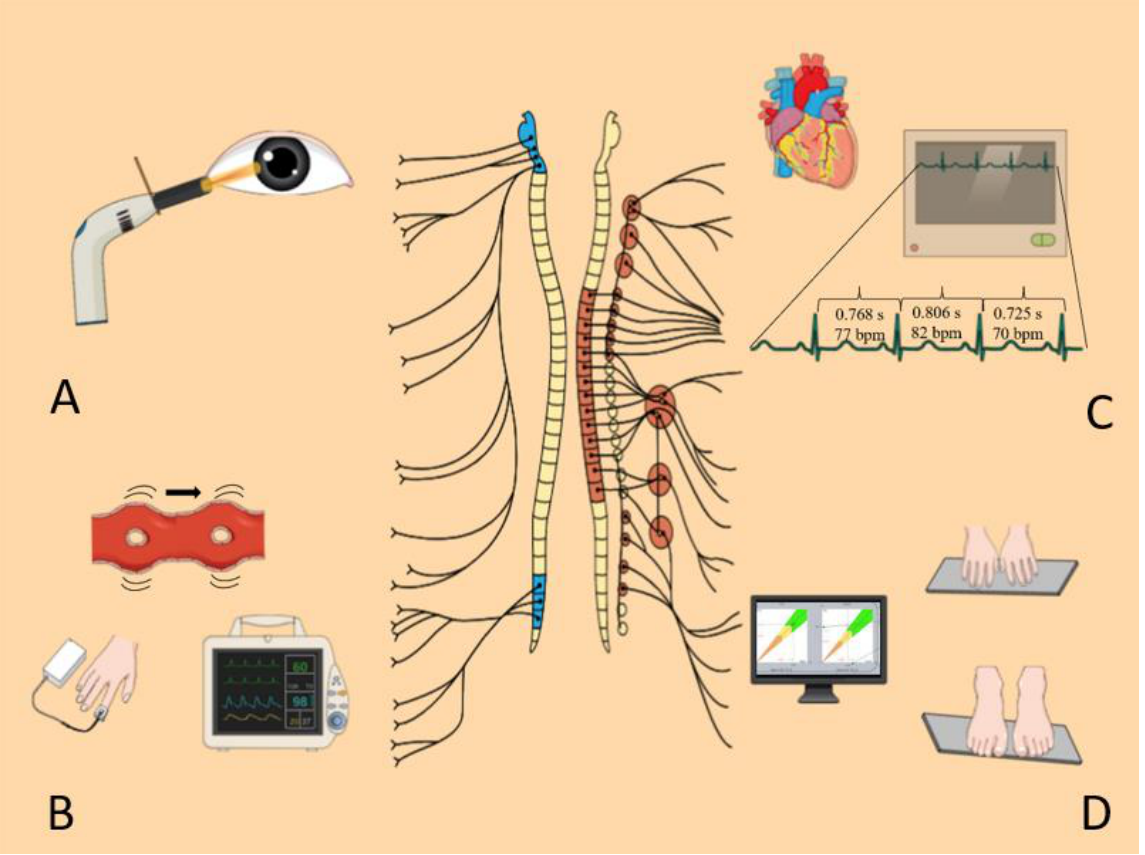
Figure 2. Overview of the techniques used in the study. Panel ( A ) Automated pupillometry (AP) measures the pupil’s light response (PLR) parameters, allowing an indirect evaluation of sympathetic/parasympathetic system modulation. Panel ( B ) Pulse transit time (PTT) was measured by means of a pulse oximeter placed on the index. PTT corresponded to the time lapse between the detection of the R peak on EKG and the peaks in the pulse oximetric signals. Panel ( C ) Heart rate variability (HRV) measurements are based on the variability in the interval between consecutive R peaks as well as the oscillation between consecutive instantaneous heart rates. Panel ( D ) Sudoscan stimulates sweat glands with low voltage direct current and induces an electrochemical reaction between sweat chloride and the stainless-steel electrodes. The parameter obtained is the electrochemical skin conductance (ESC), indirectly evaluating small fibers’ function.